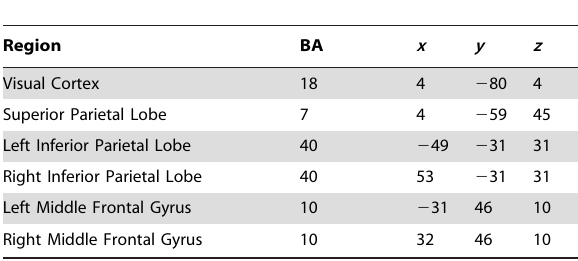
Table 1. Involved